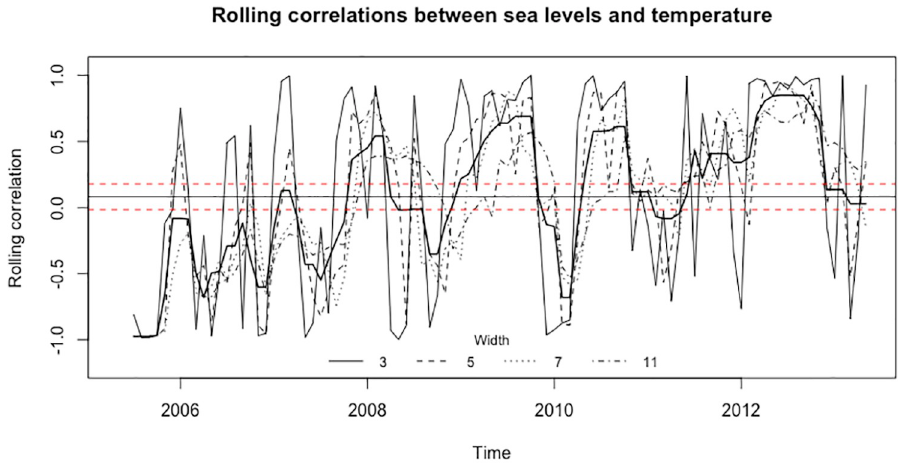
Fig 1. Rolling correlations between the monthly GMSL and mean land-ocean temperature